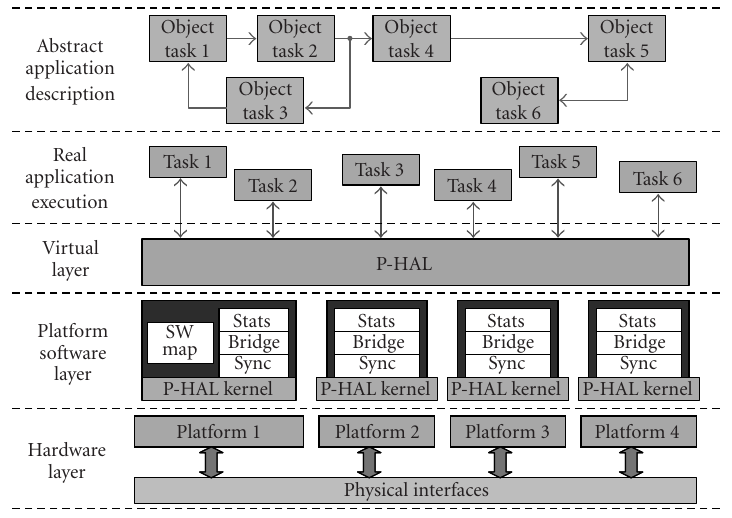
Figure 1: Representation of the platform abstraction